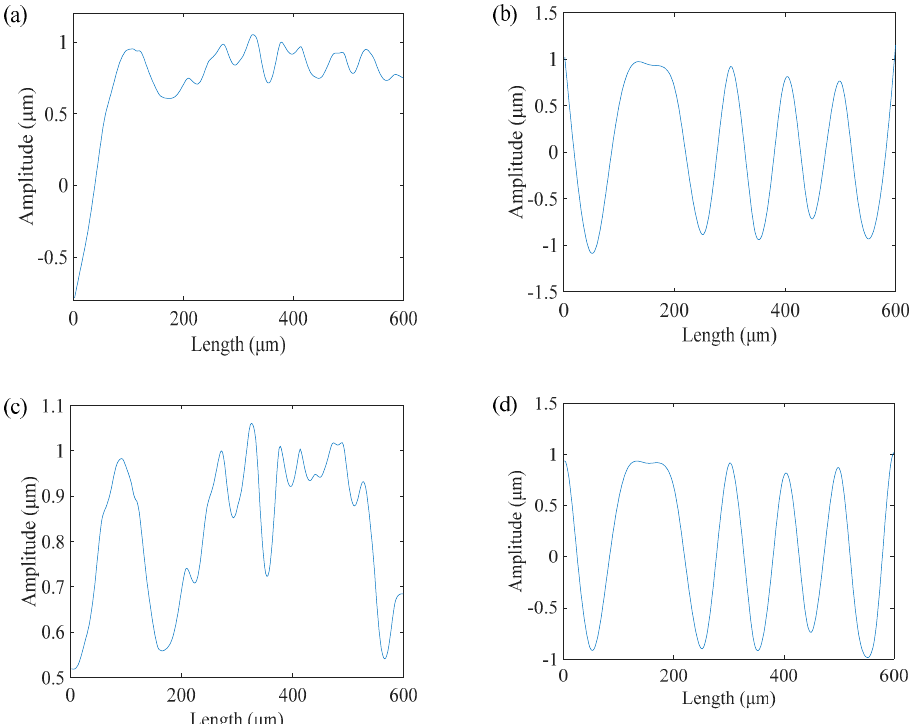
Figure 5. Comparison of a BIMF before and after processing: ( a ) 2D cross section of a BIMF of raw data in x direction; ( b ) 2D cross section of a BIMF of raw data in y direction; ( c ) 2D cross section of a BIMF in x direction after processing; ( d ) 2D cross section of a BIMF in y direction after processing.